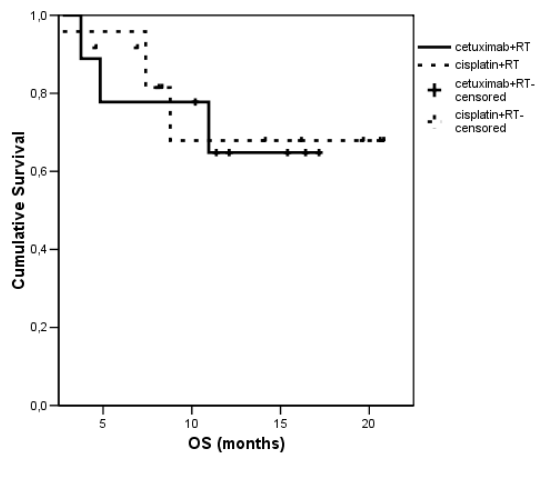
Figure 1. Univariate analysis for OS considering concomitant cisplatin-radiotherapy vs concomitant cetuximab-radiother- apy